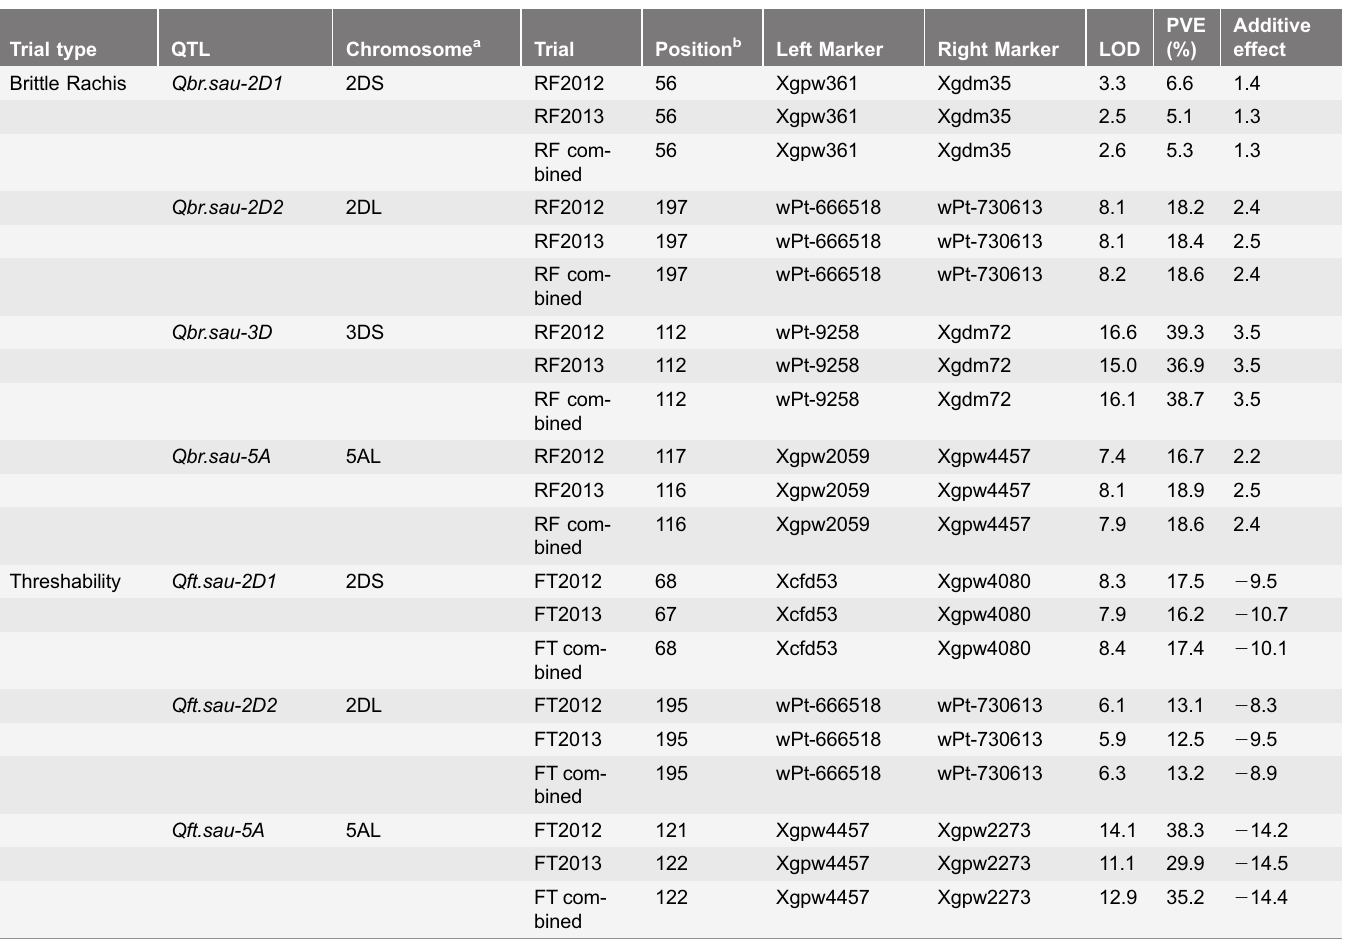
LOD: limit of detection; PVE: phenotypic variation explained. a Markers on the chromosome arm are considered to be linked with the QTL. b The position of LOD score peak in the chromosomes (Figs.